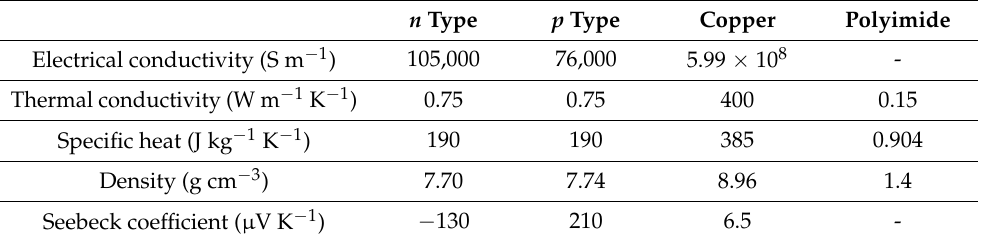
Table 1. Physical properties of the materials considered in the numerical simulations.